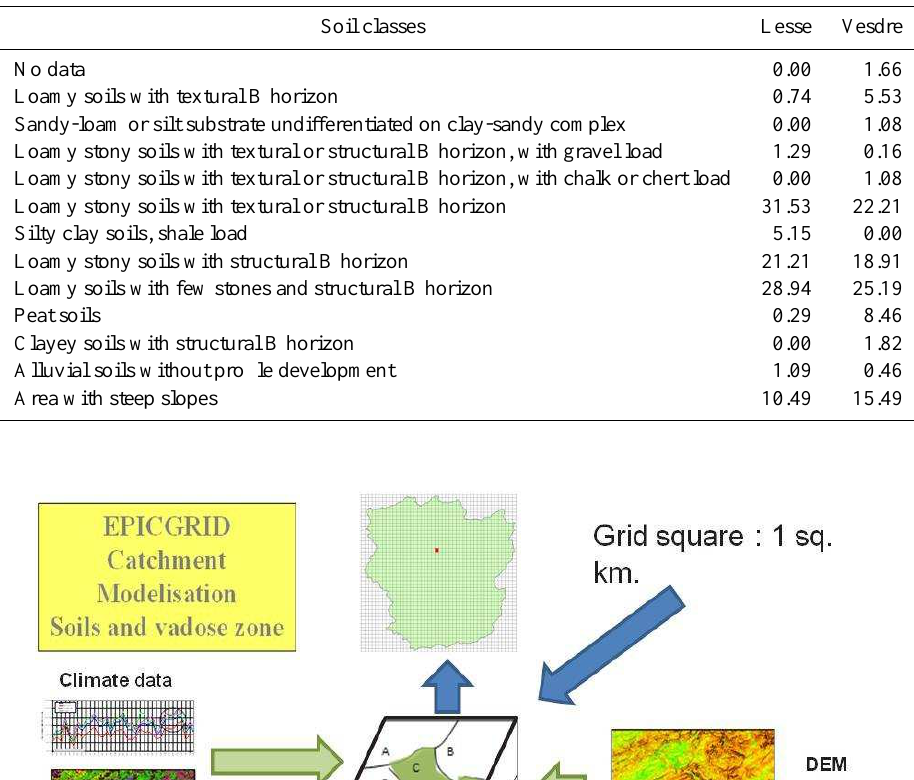
Table 1. Distribution of soil classes (%) for the Lesse and the Vesdre catchments, based upon the Belgian simplified pedological map at 1/50000.